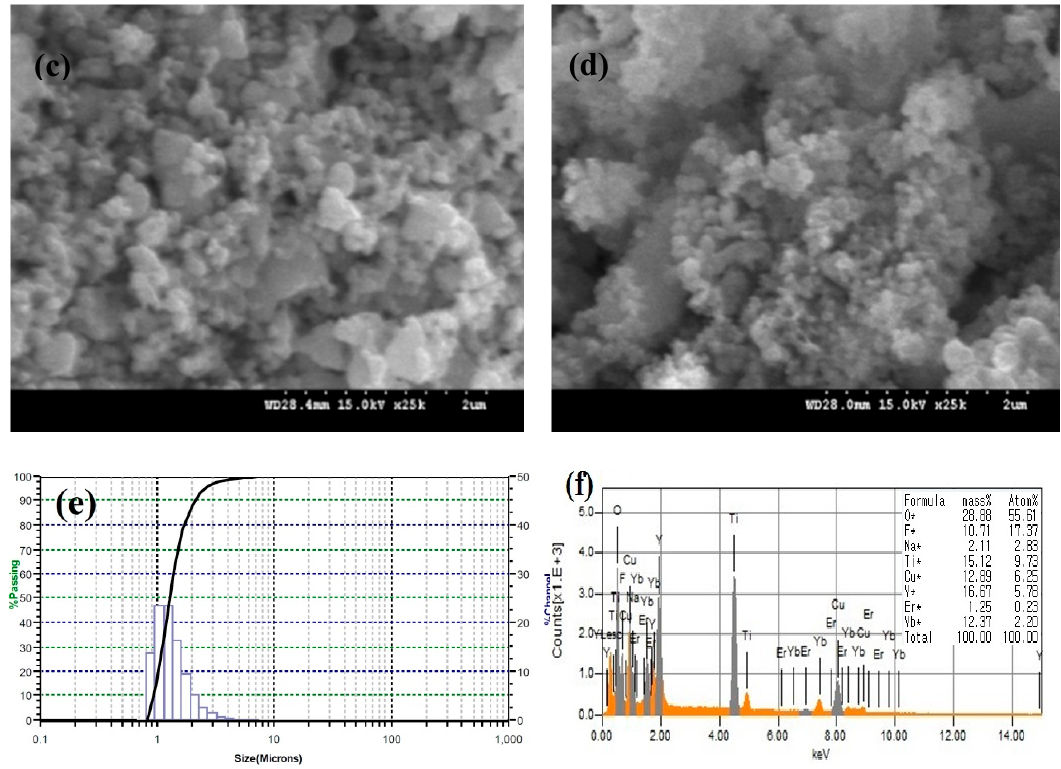
Figure 2. SEM images of ( a ) NaYF 4 :(Yb,Er), × 25k, ( b ) CuO, × 9k, ( c ) NaYF 4 :(Yb,Er)-CuO, × 25k, ( d ) NaYF 4 :(Yb,Er)-CuO/TiO 2 , x25k, ( e ) particle size distribution of NaYF 4 :(Yb,Er)-CuO/TiO 2 composite and ( f ) EDS spectra for the NaYF 4 :(Yb,Er)-CuO/TiO 2 composite.